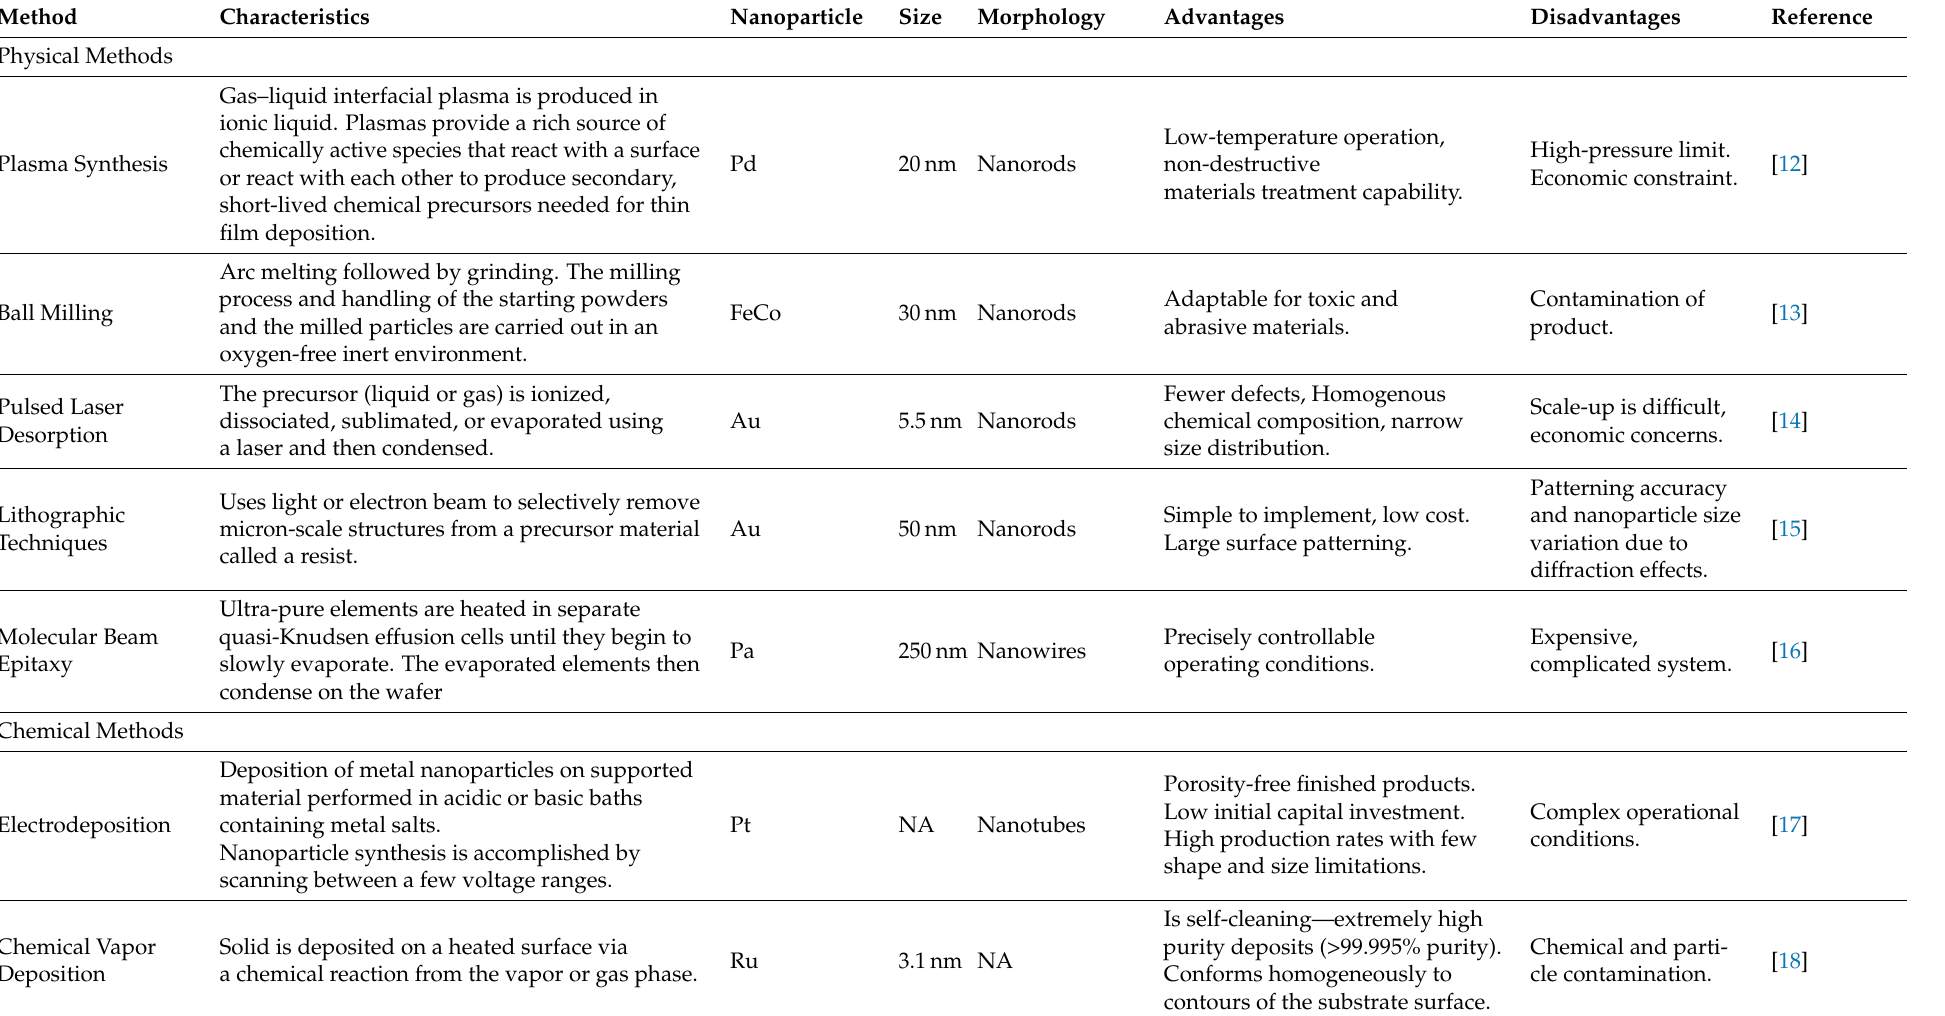
Table 1. Traditional approaches reported for the synthesis of metallic